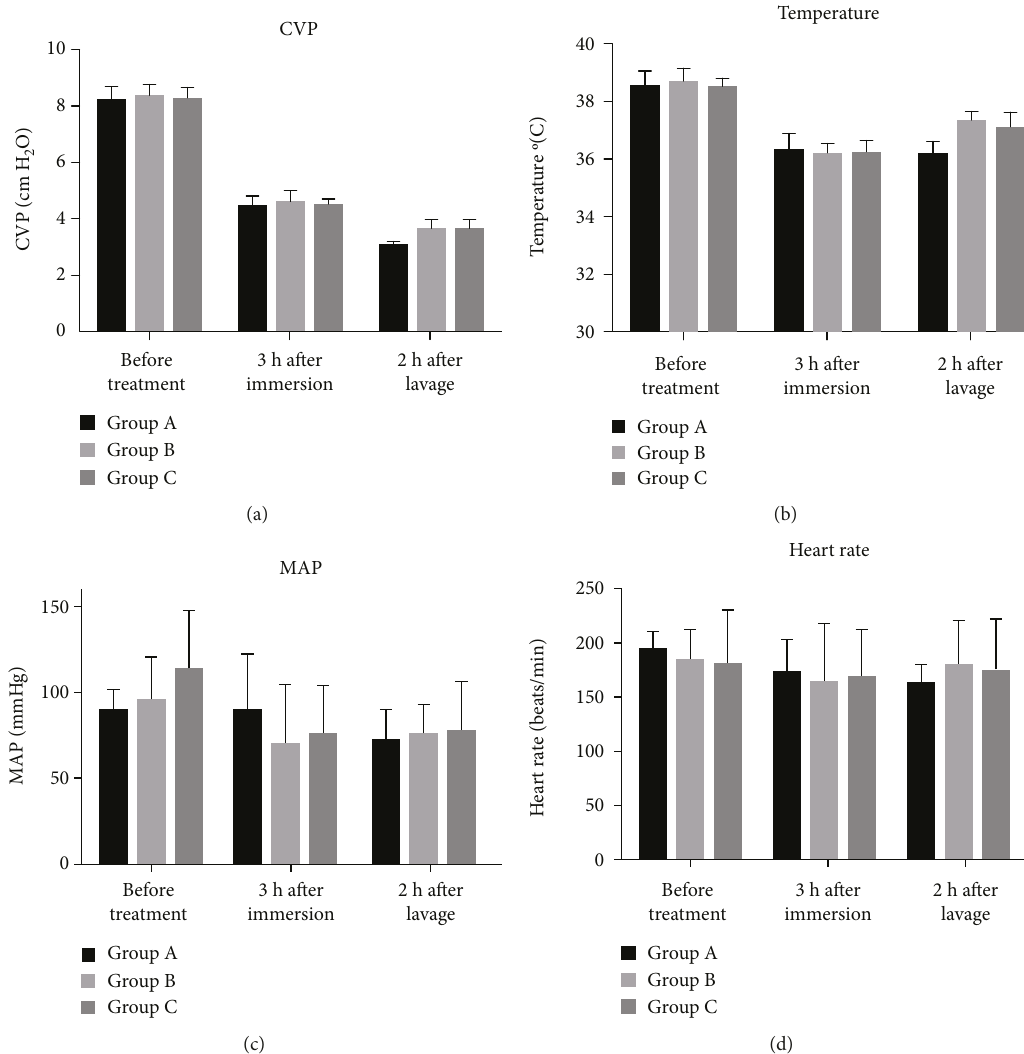
Figure 2: Comparison of the vital signs among di ff erent groups. Dogs were treated with delayed lavage (group A), timely lavage (group B), and timely lavage with peritoneal lavage device (group C); the CVP, MAP, temperature, and heart rate were detected at each time point. CVP: central venous pressure; MAP: mean artery